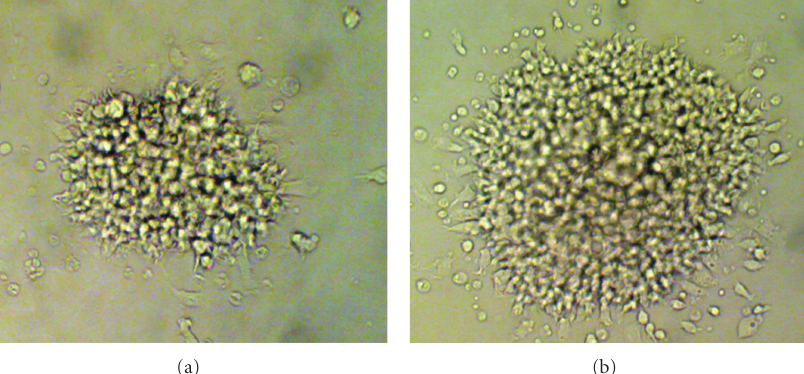
Figure 8: (a) Colony Forming Unit-Fibroblast (CFU-F) in Normal. (b) Colony Forming Unit-Fibroblast (CFU-F) in Aplastic